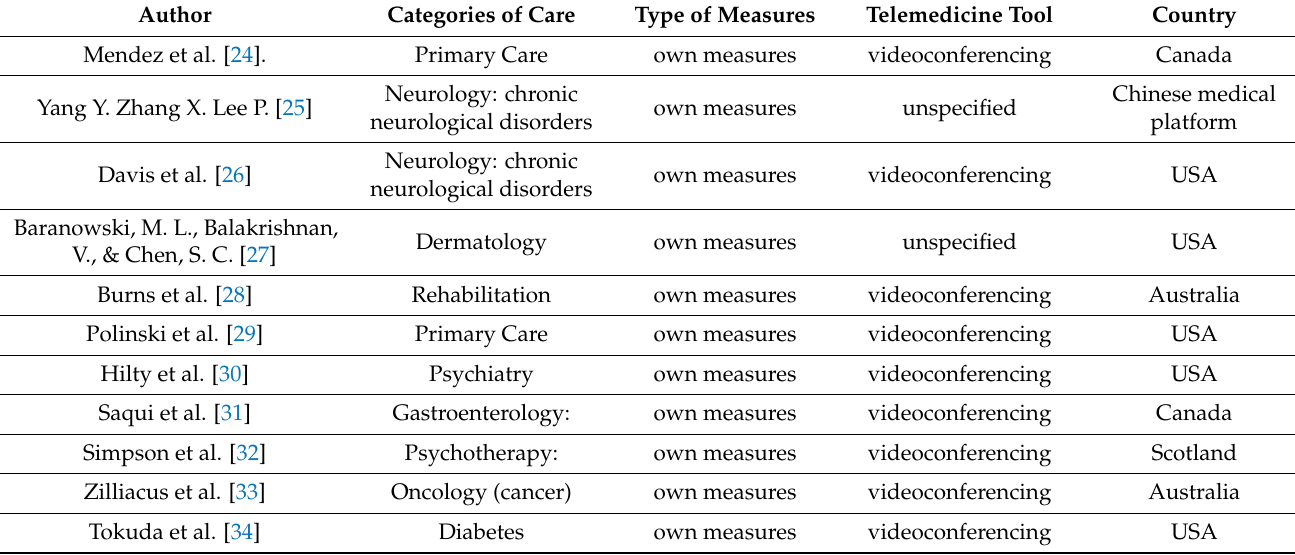
Table 1. Selected characteristics of the research on patient satisfaction prior to the Covid-19 pandemic. Author Categories of Care Type of Measures Telemedicine Tool Country Mendez et al.